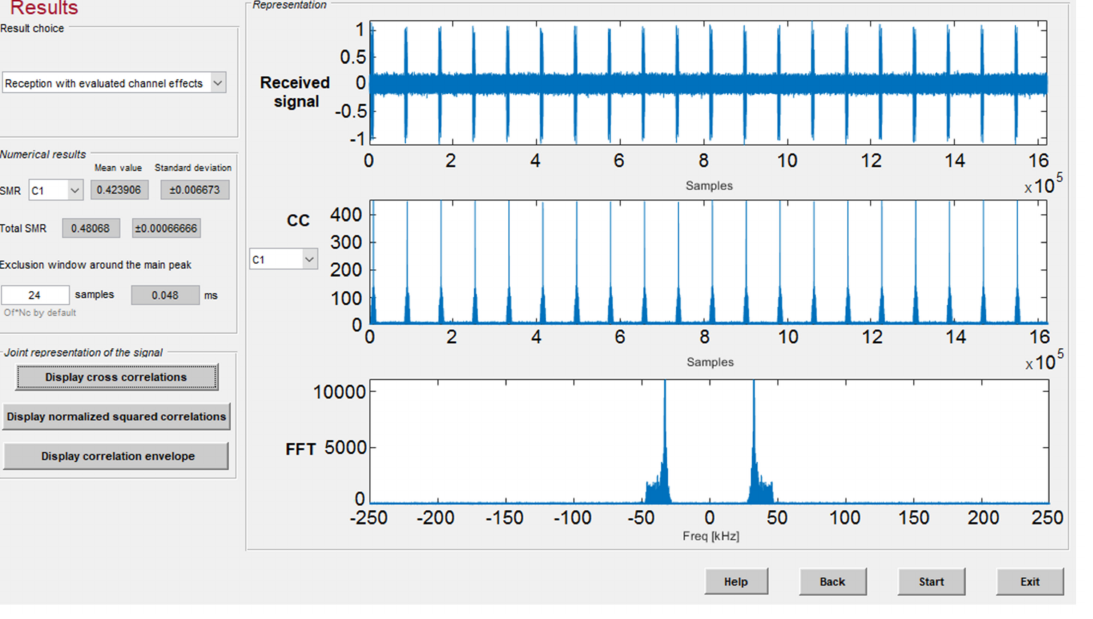
Figure 12. Correlation results after the emission of five simultaneous 255-bit BPSK modulated codes with SNR = 5 dB.